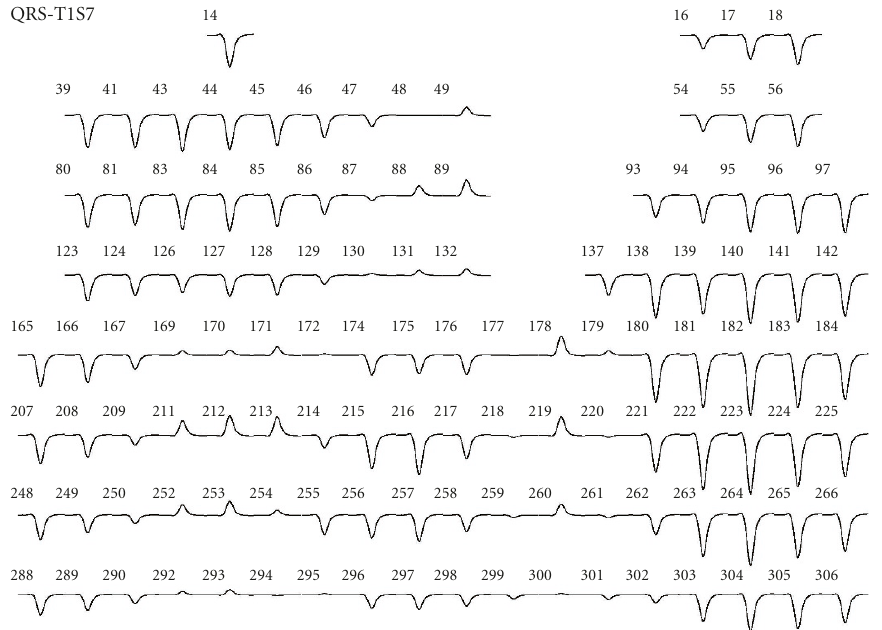
Figure 15: Basis function B n , l = t n s T derived from the BSPM data displayed in Figure 13, assuming a separable structure of the time-lead l correlation matrix ( n = 1, l =